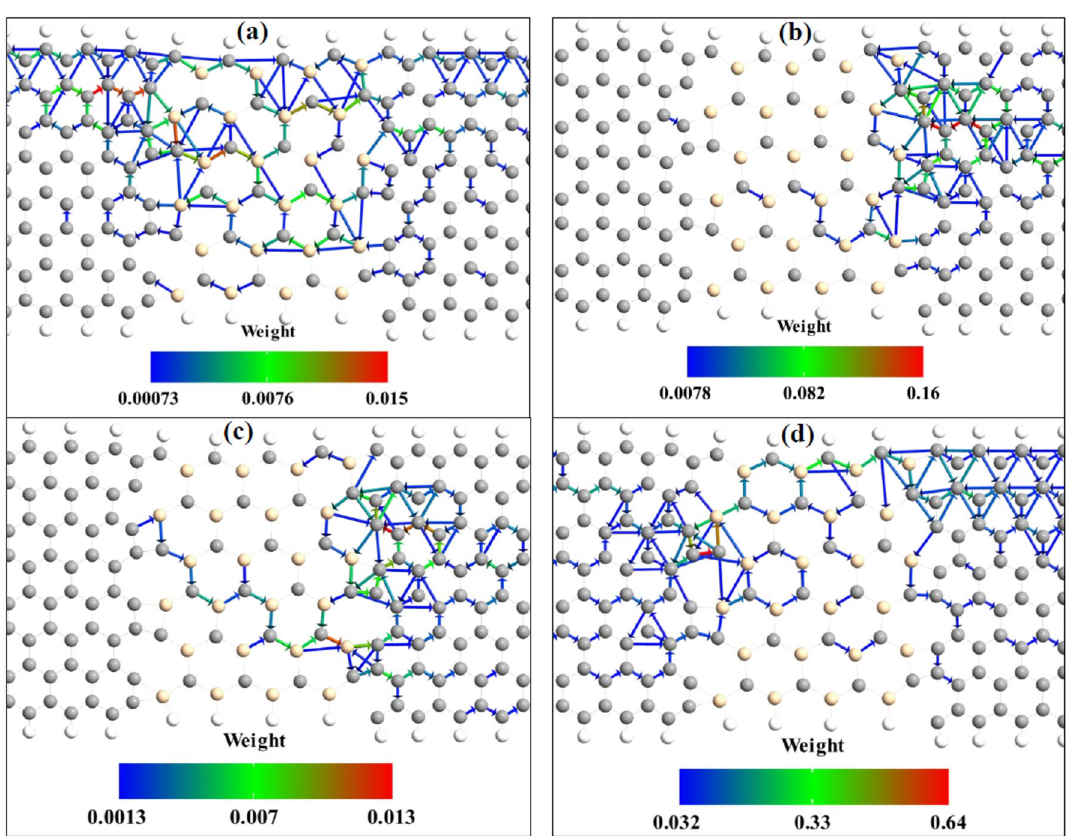
Figure 3. The spin-up ( a and c ) and spin-down ( b and d ) electron transmission pathway of SiCNR junction in P ( a and b ) and AP ( c and d ) configurations. Forward and backward arrows show the direction of transmission pathway to the right or left and the weight of the transmission pathway between the atoms are represented by the color according to the color